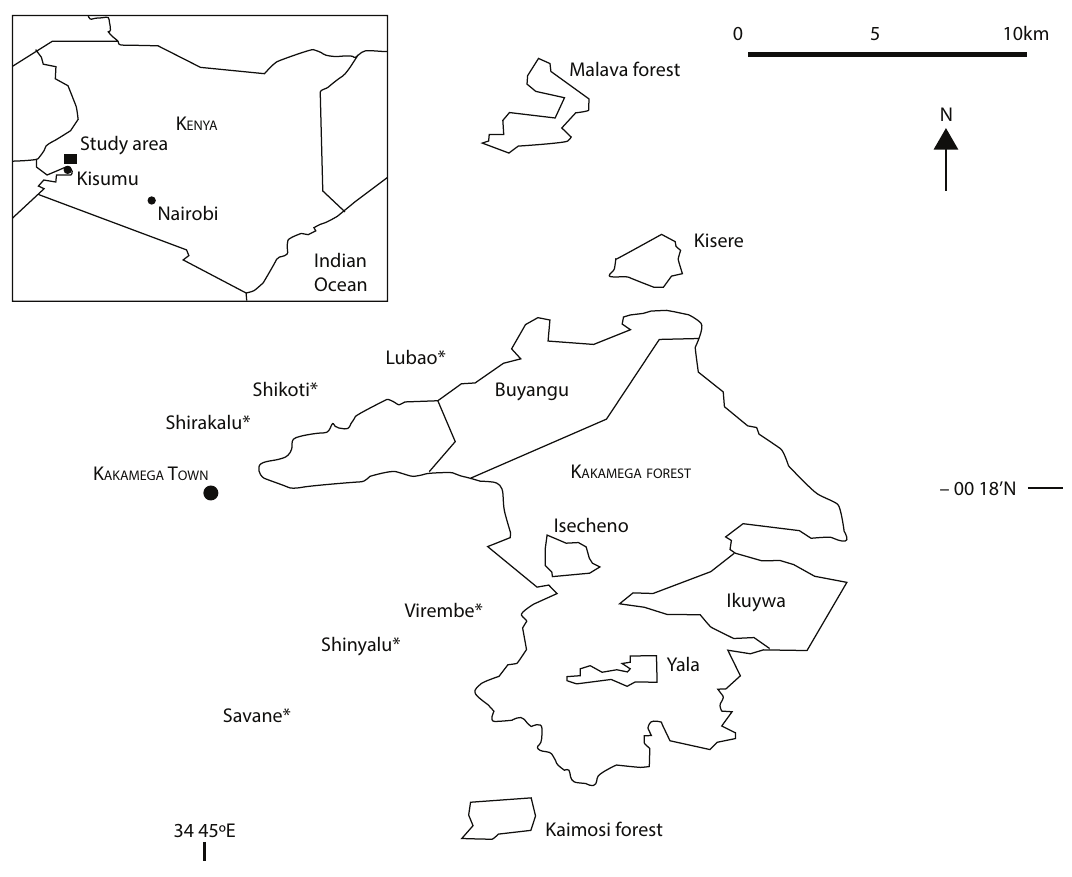
Figure 1. Map of Kakamega forest (this figure has been reproduced with kind permission from Otieno and co-authors 13 ).